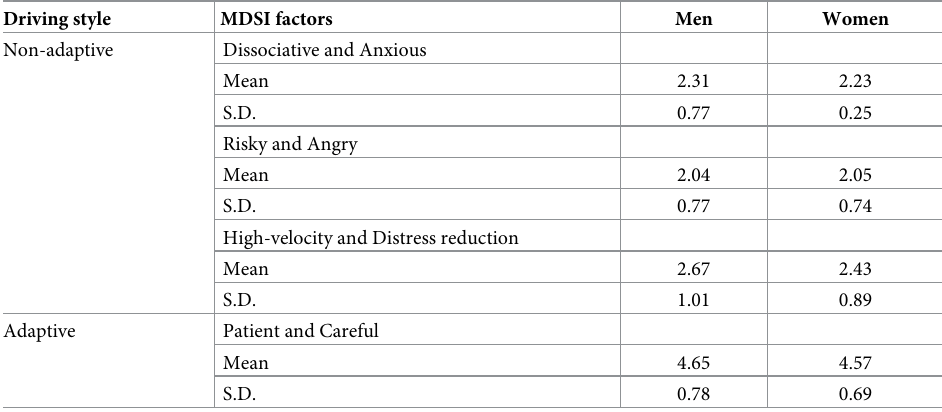
Table 2. Driving style score according to